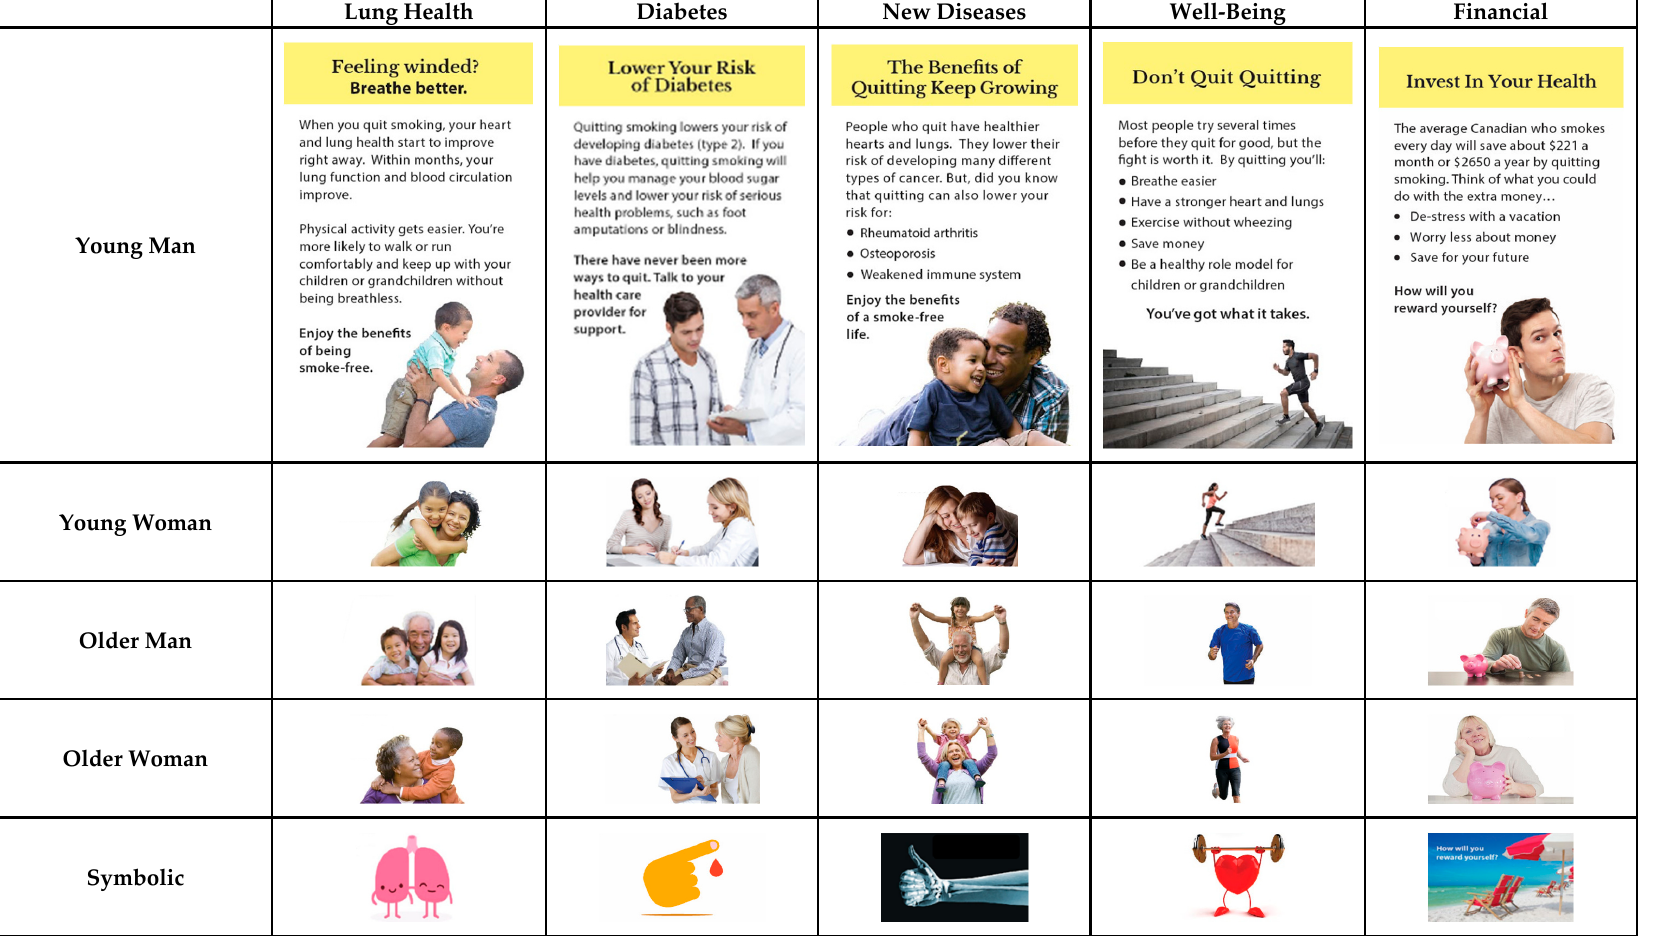
Figure 1. Topic and imagery for cessation benefit messages in DCE 1.